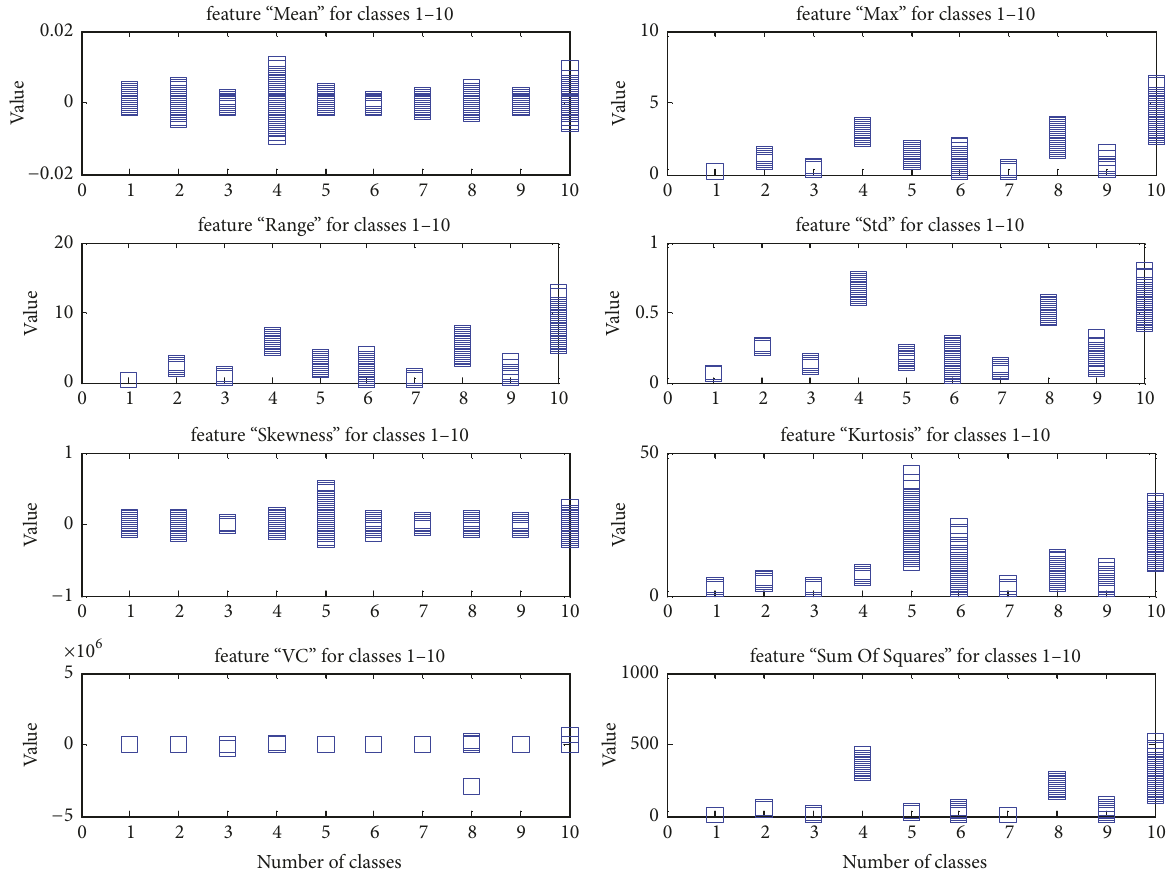
Figure 6: Box plots of the eight features for different classes.